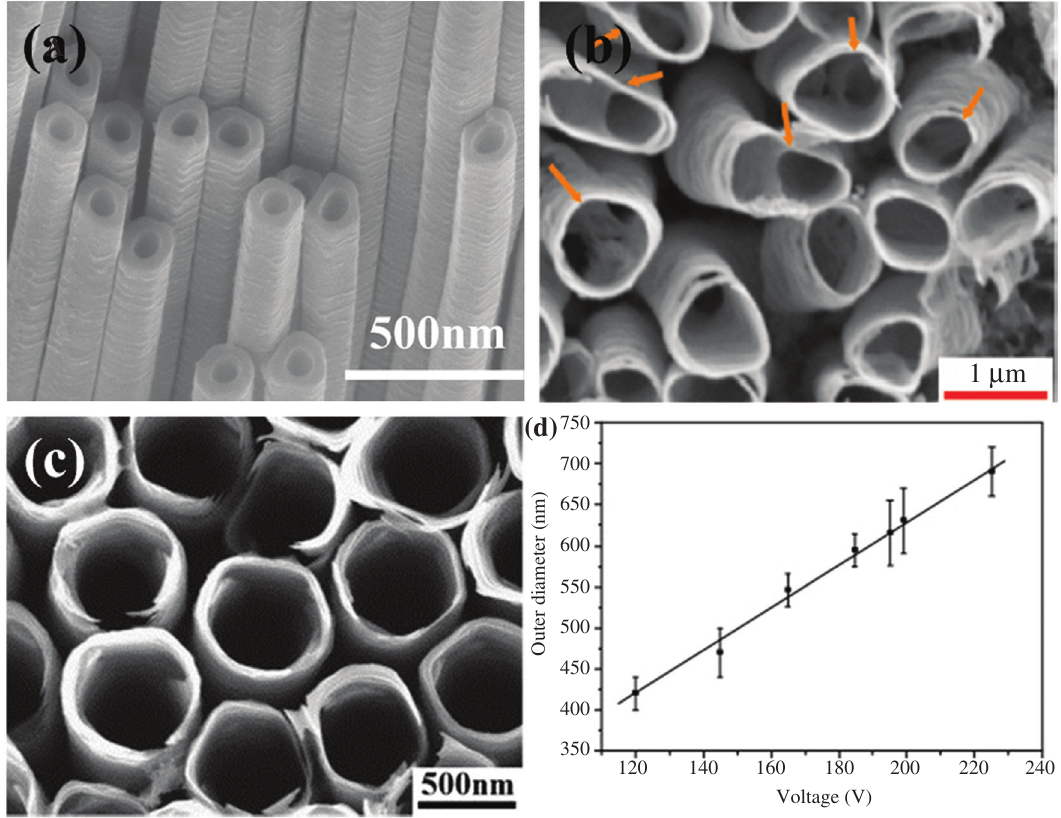
NT array synthesized under traditional conditions (at a low voltage of 60 V for 1.5 h 2 F and 3% H O). (B) The TiO NTs with surface diameter > 600 nm, which were fabricated by 4 2 2